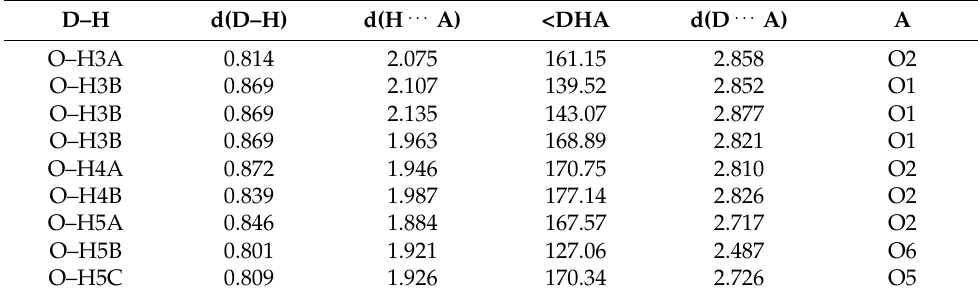
Table 6. Hydrogen bonding geometry (Å, ◦ ) for natrophosphate ( D = donor; A = acceptor).